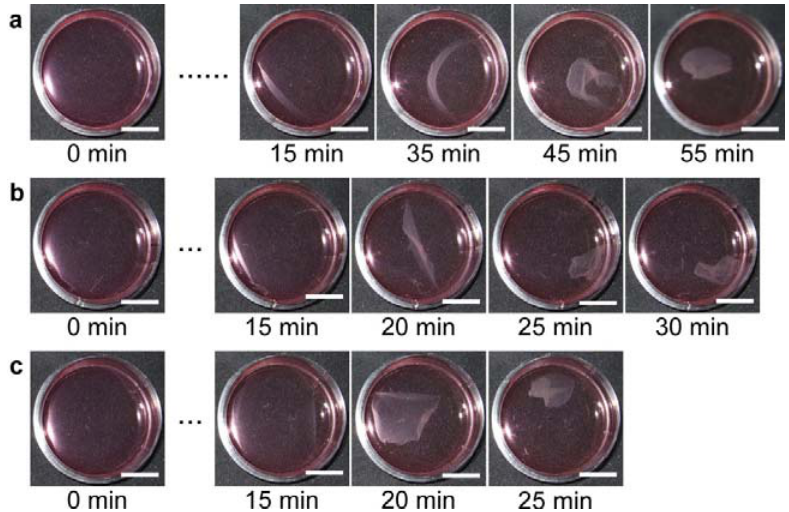
Figure 7. Macroscopic view of cell sheet detachments from ( a ) PIPAAm gel modified tissue culture polystyrene (TCPS) dish (PIPAAm-TCPS); ( b ) comb-type grafted PIPAAm gel modified TCPS with 1.0 wt % macromonomers (1.0 ctPIPAAm-TCPS) and ( c ) comb-type grafted PIPAAm gel modified TCPS with 1.0 wt % macromonomers (5.0 ctPIPAAm-TCPS) at 20 °C. Scale bar: 10